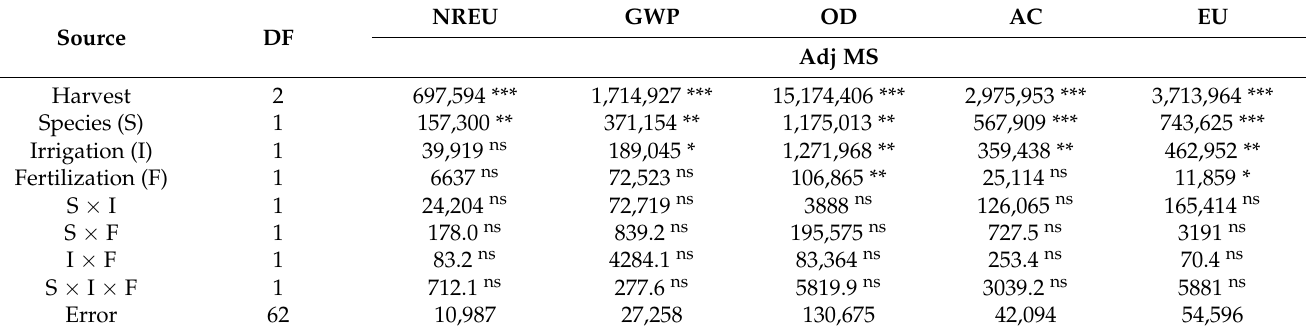
Table 2. Repeated measures ANOVA for main effects and interactions on impact categories of Arundo donax and Miscanthus × giganteus . Degree of freedom (DF), adjusted mean square (Adj MS), and significance: p ≤ 0.001 (***), p ≤ 0.01 (**), p ≤ 0.05 (*), not significant ( ns